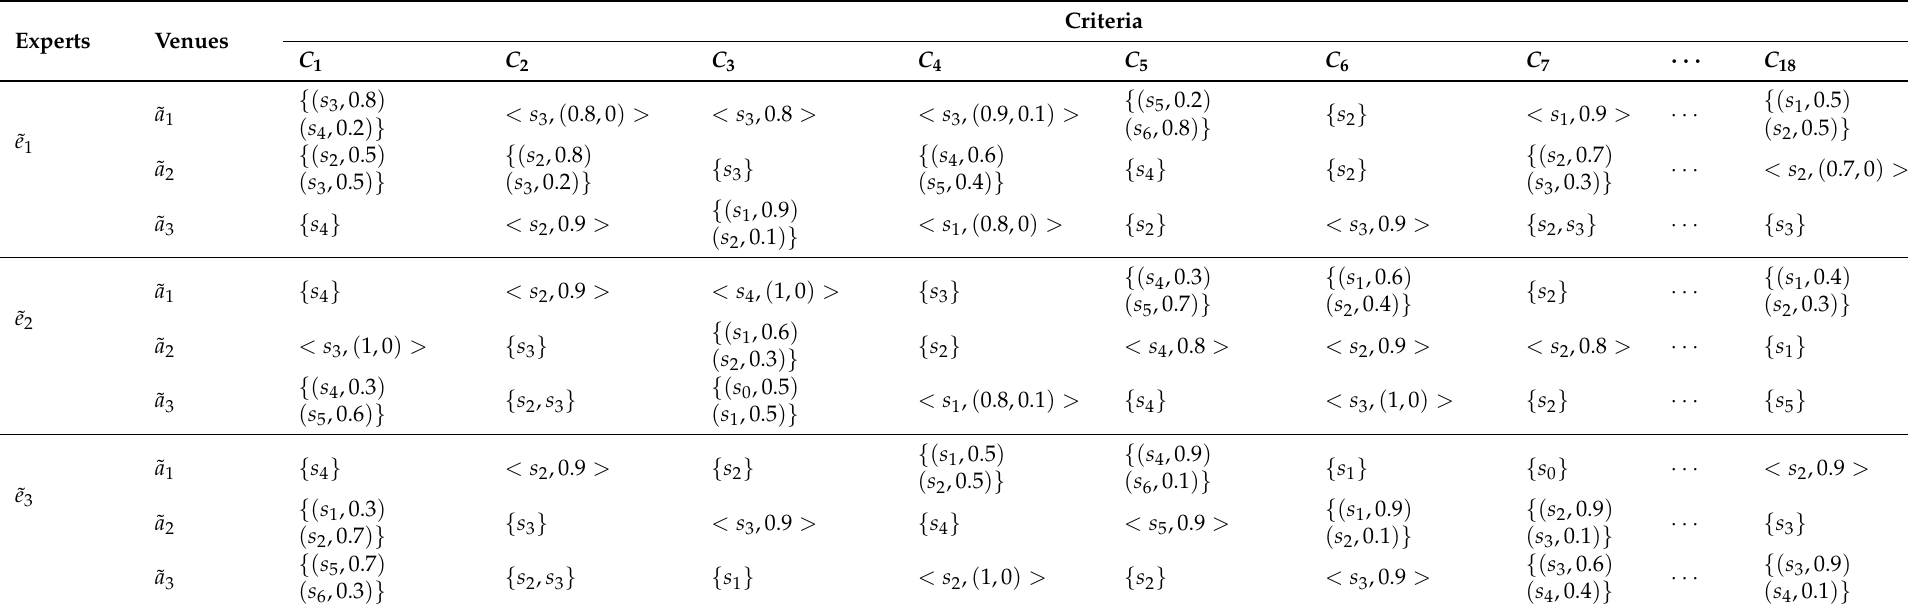
Table 3. The assessment information for public safety education